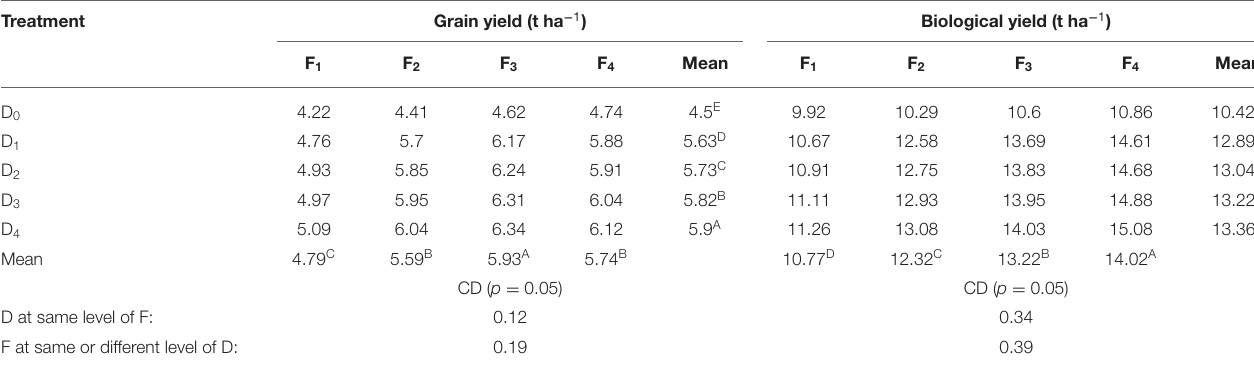
TABLE 5 | Interaction effect of fertilizer dose and time and rate of panchagavya application on grain and biological yield of hybrid basmati rice.